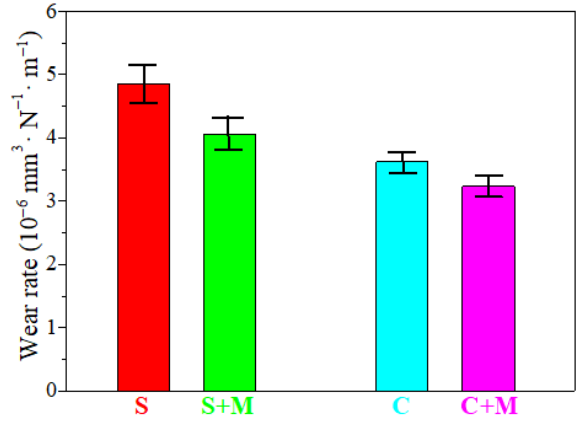
Figure 12. Predicted results of volume abrasion rate of various samples: S, Slipper substrate, C, Ni80Al20 coating, S + M, Substrate with MoS 2 film and C + M, Ni80Al20-MoS 2 composite coating.